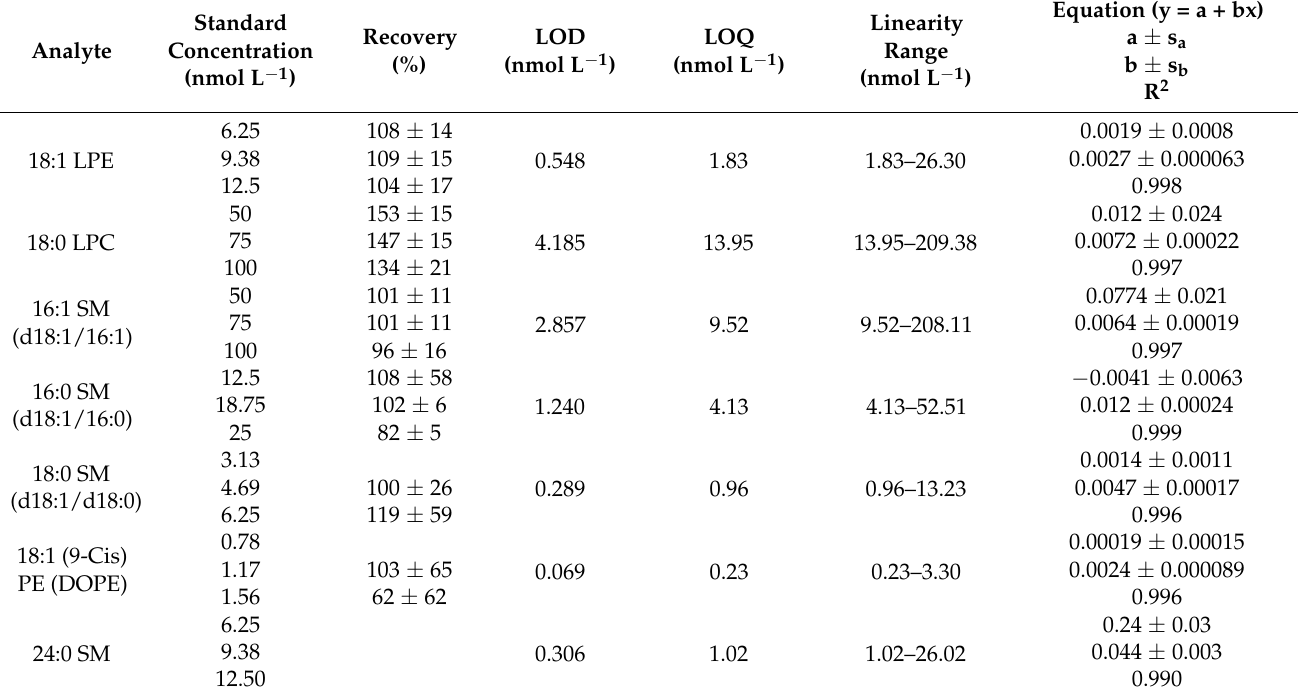
Table 4. Analytical method validation.